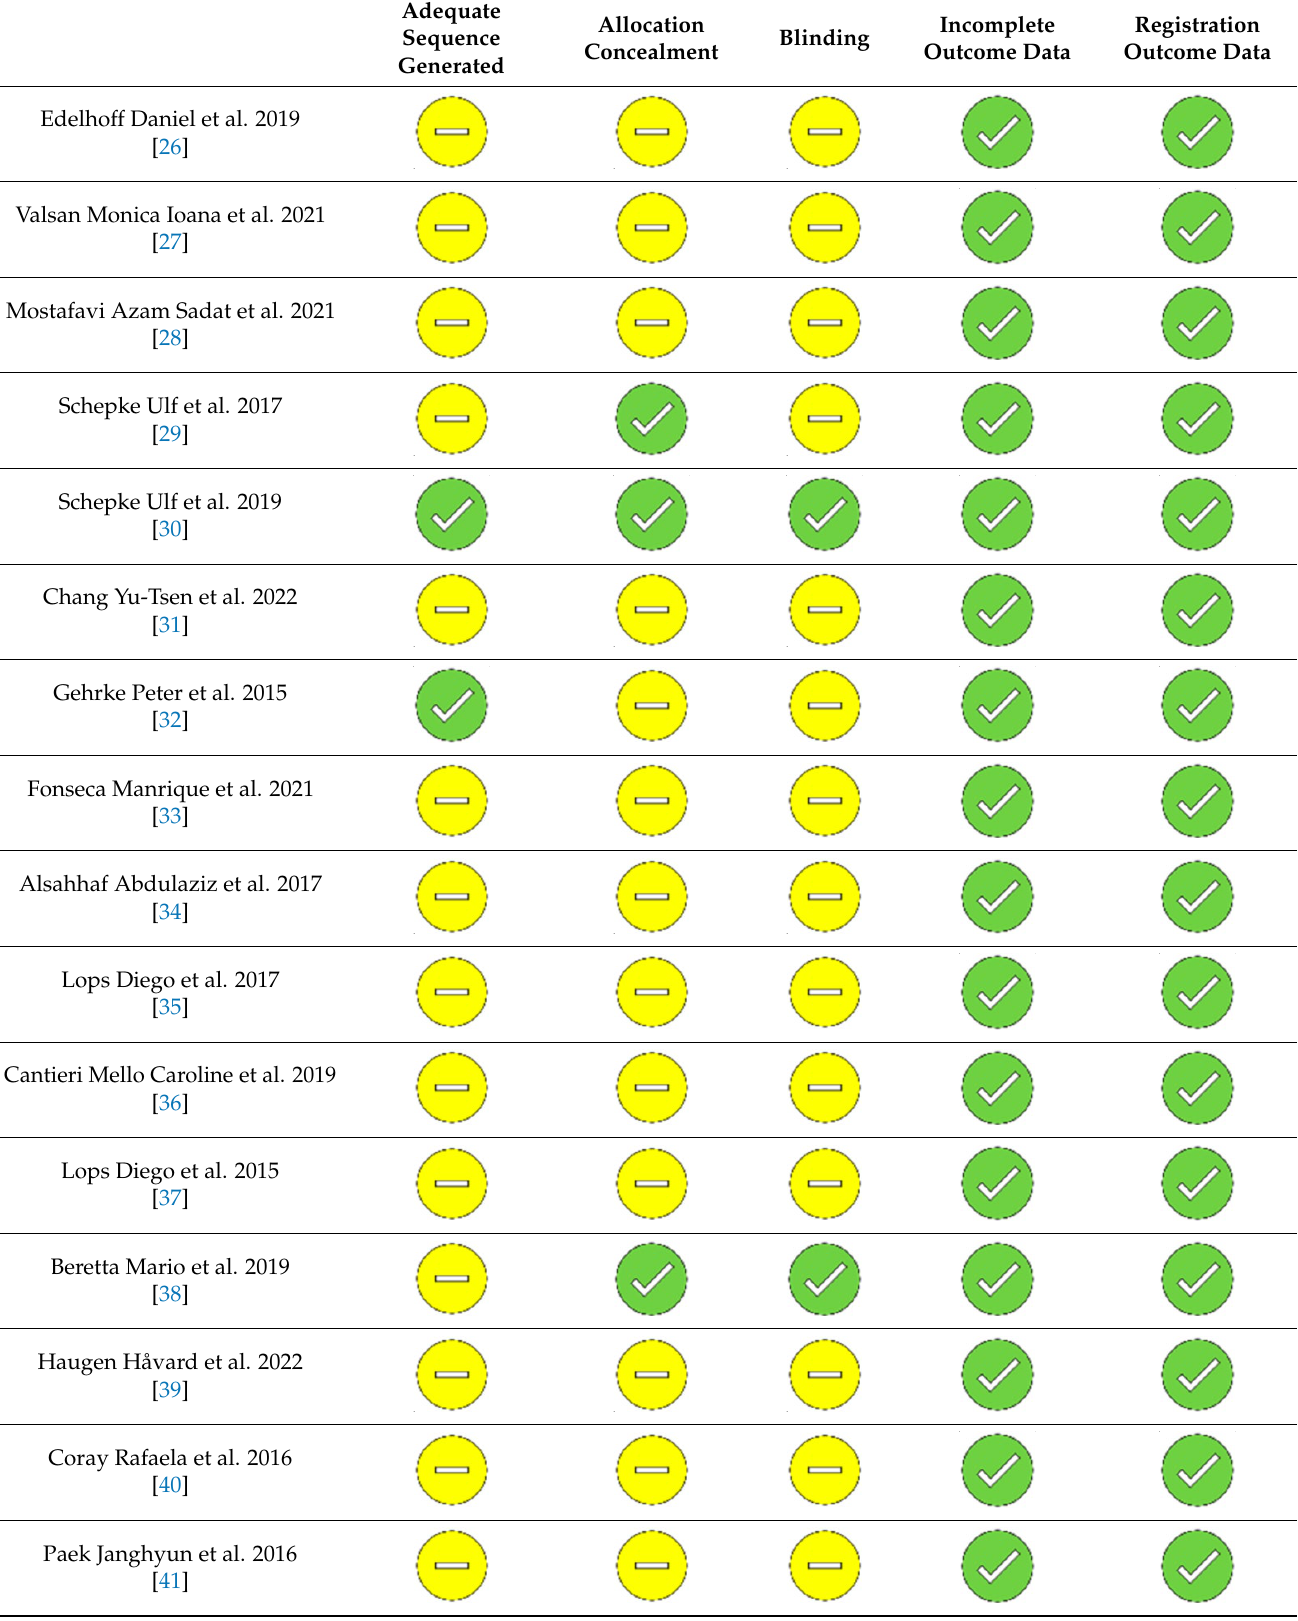
Table 1. Risk of bias of the studies is represented by the green symbol for a low risk of bias and a yellow symbol for a moderate risk of bias.